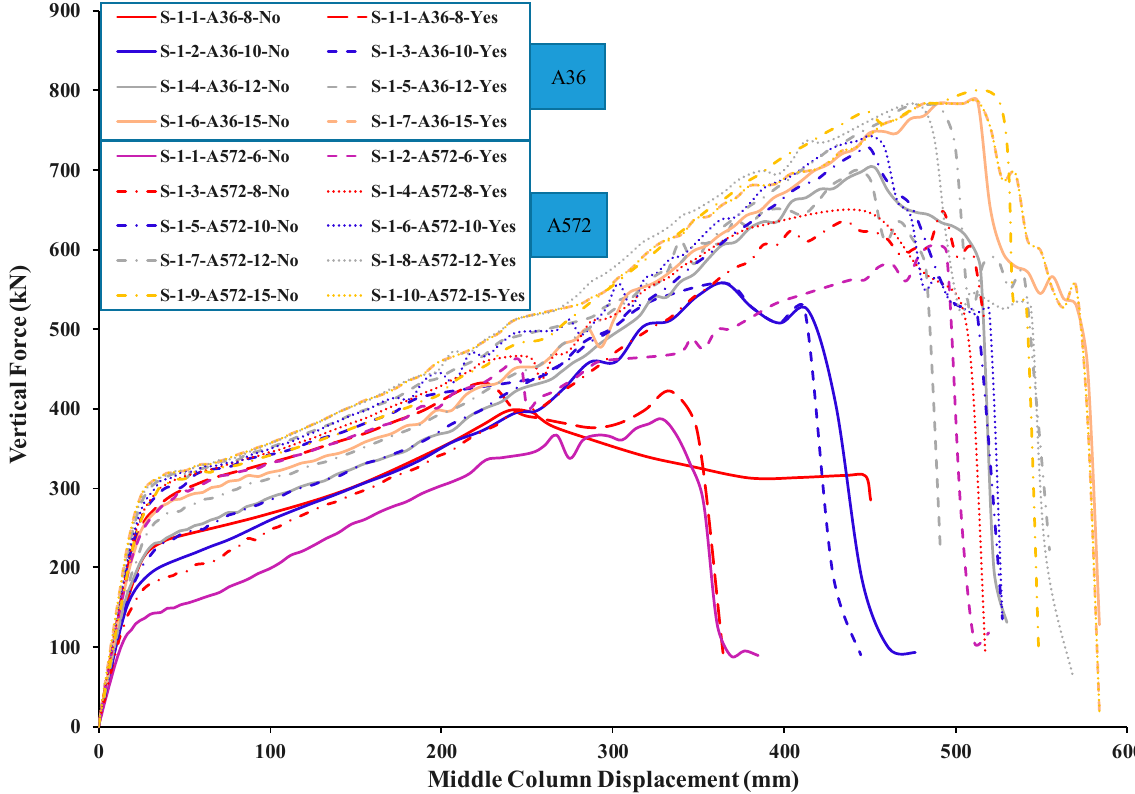
Figure 19. FEM force-displacement response for all FEM specimens. Table 8. Outcomes from parametric study of (J-S-S-EX).